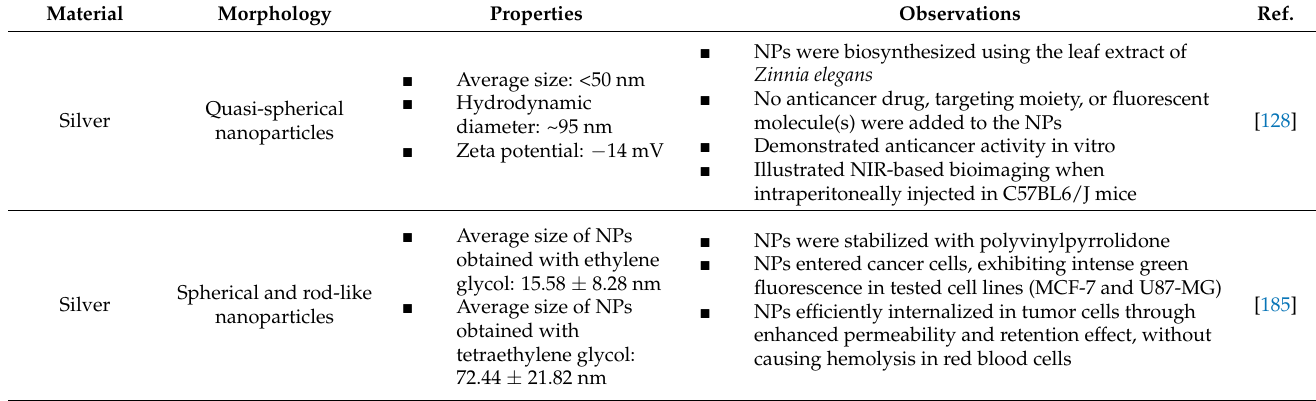
Table 5. Examples of recently developed metal-based